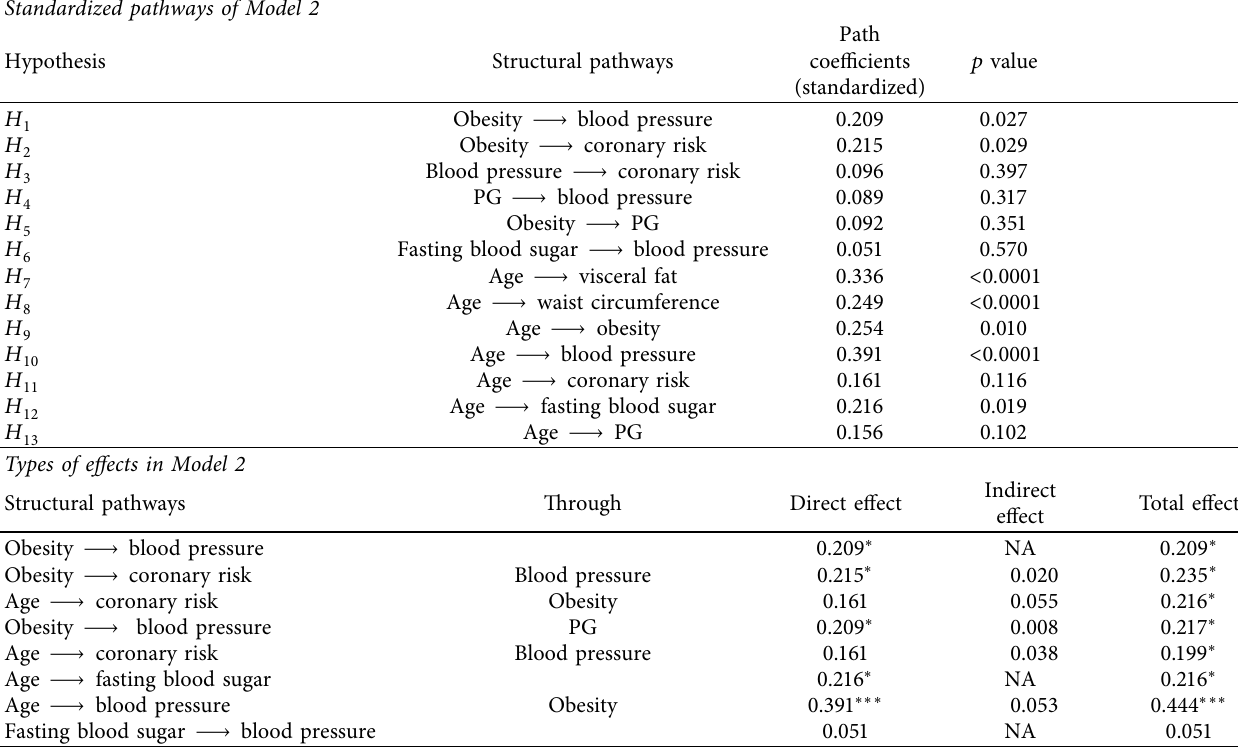
Table 5: Standardized pathways and type of effects of Model 2.